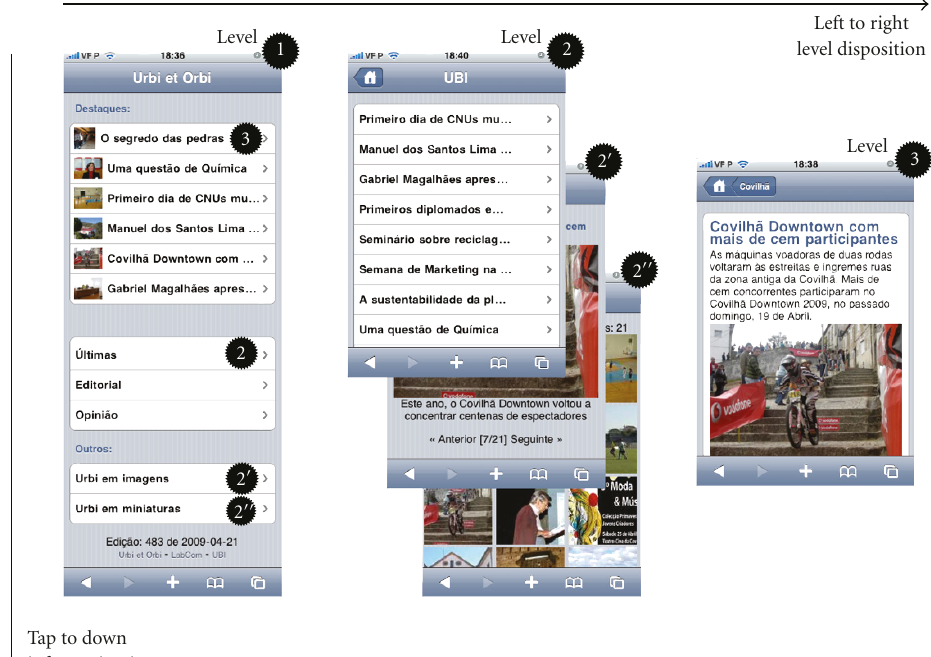
Figure 1: “Mobile” Web application structure and screenshots.